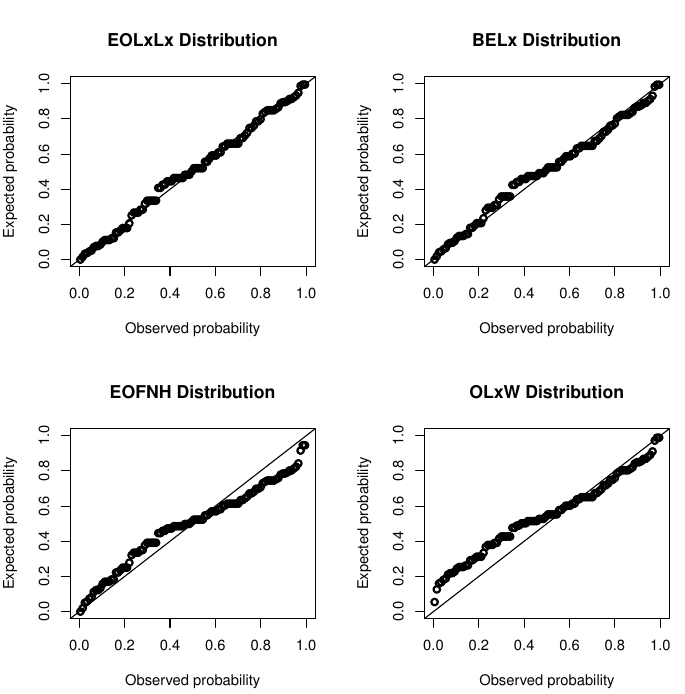
Figure 9 – P-P plots of EOLxPL, KwTLL, OLxLL and OP